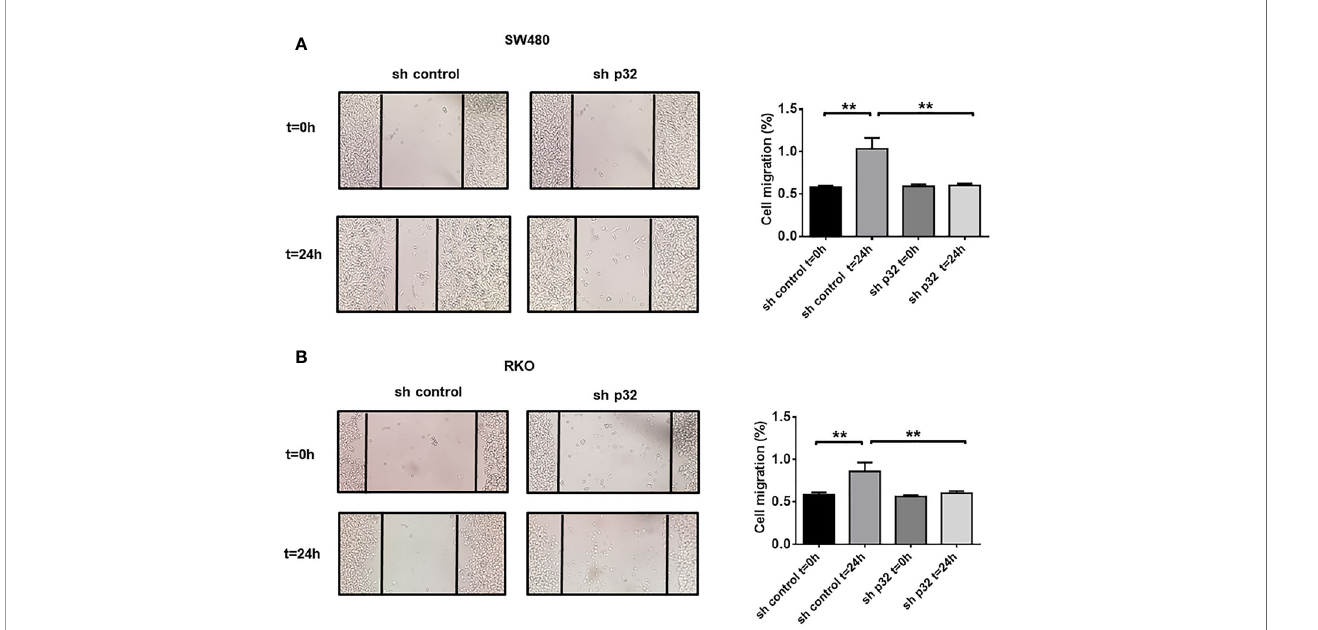
FIGURE 4 | Knockdown of p32 affects the migratory capacity of SW480 and RKO cells. Wound healing assay for SW480-sh control and SW480 sh-p32 (A) or RKO sh-control and RKO sh-p32 (B) was performed as described under the Materials and Methods section. Representative images from 3 independent experiments are shown. The data is presented as the mean values ± SEM from at least three independent experiments, **p <